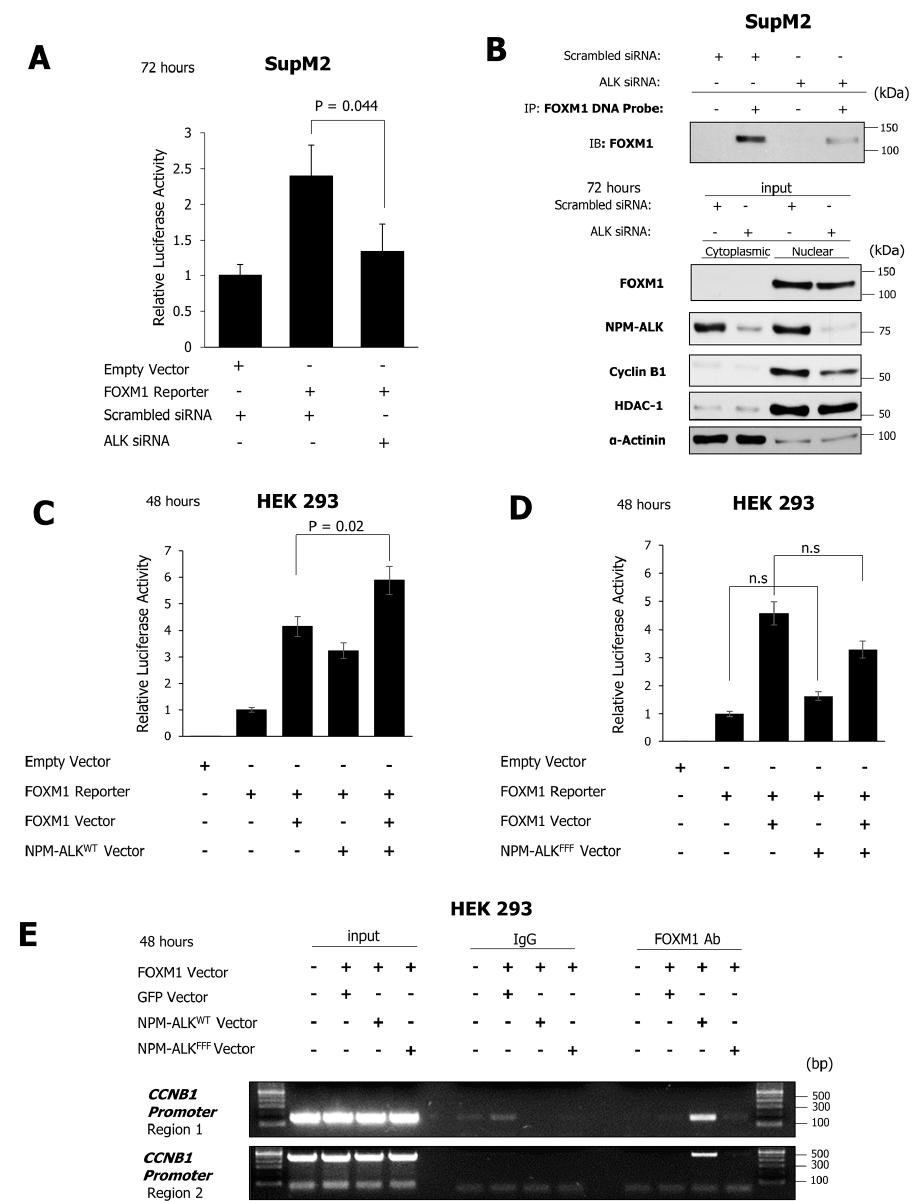
Figure 6. NPM-ALK promotes the transcriptional activity of FOXM1. ( A ) Cells co-transfected with siRNA to ALK or a scrambled sequence in the presence or absence of a FOXM1 consensus specific-luciferase reporter construct were assessed for luciferase activity at 72 h. ( B ) Analysis of FOXM1 binding to a FOXM1 consensus DNA sequence probe following siRNA-mediated inhibition of NPM-ALK expression at 72 h ( C , D ). FOXM1 luciferase reporter activity was measured at 48 h in HEK 293 cells following co-transfection of FOXM1, NPM-ALK WT , or NPM-ALK FFF vectors. ( E ) PCR amplification of two promoter regions of CCNB1 (Cyclin B1 promoter) was performed following chromatin immunoprecipitation with a control IgG or FOXM1 antibody in HEK 293 cells, co-transfected with FOXM1, and either NPM-ALK WT or kinase-dead NPM-ALK FFF expression vectors for 48 h. Data are representative of two biological replicates. n.s: not